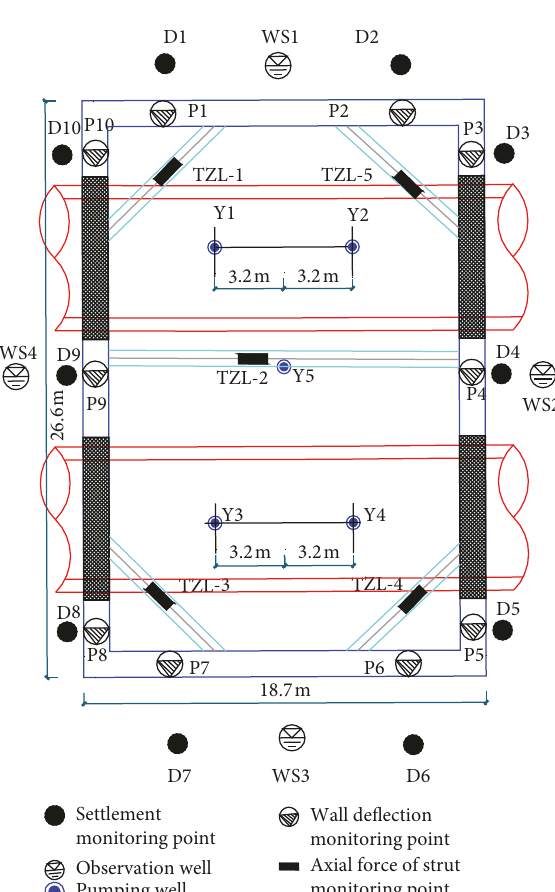
Figure 10: Instrumentation locations.